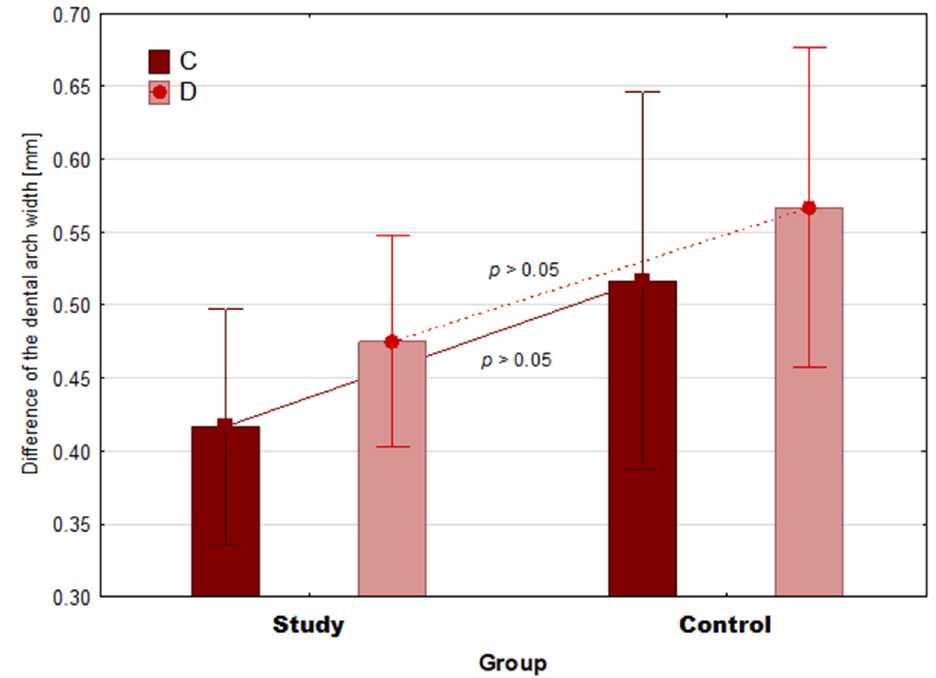
Figure 5. The 10-month mean difference in mandible parameters in the groups. The p value relates to the Student’s t -test. Whiskers show 95% confidence intervals. C—the anterior width of the lower dental arch; dimension D—the posterior width of the lower dental arch.